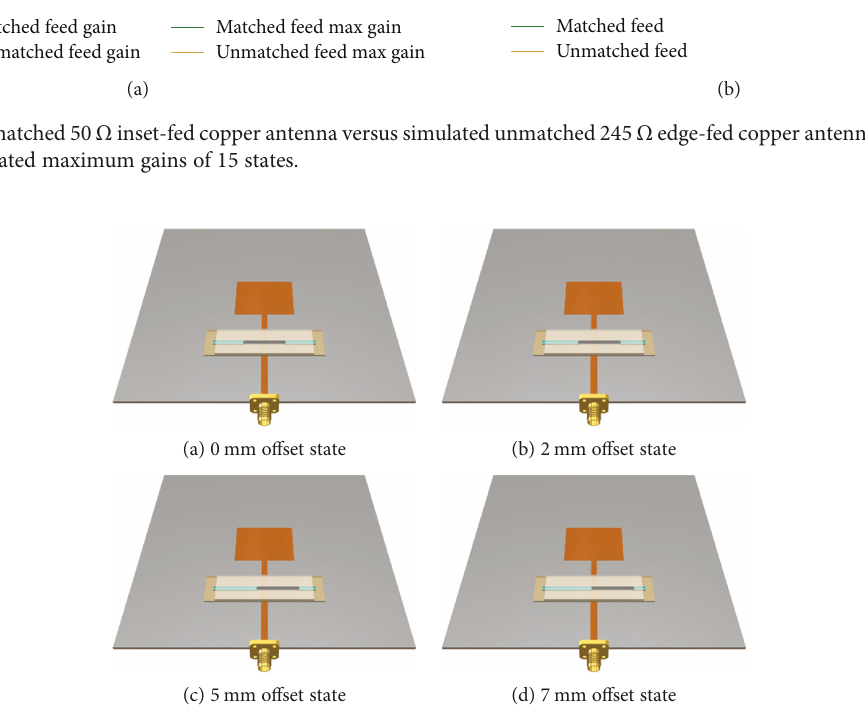
Figure 4: Liquid-metal gain-recon fi gurable antenna states. (a) 0 mm o ff set state: the midpoint of the Galinstan slug coincides with the center of the 50 Ω copper microstrip feed line; (b) – (d) X -mm-o ff set state: the midpoint of the Galinstan slug is X mm from the center of the microstrip feed line. The Galinstan slug is 1.5 × 15 × 0.6mm 3